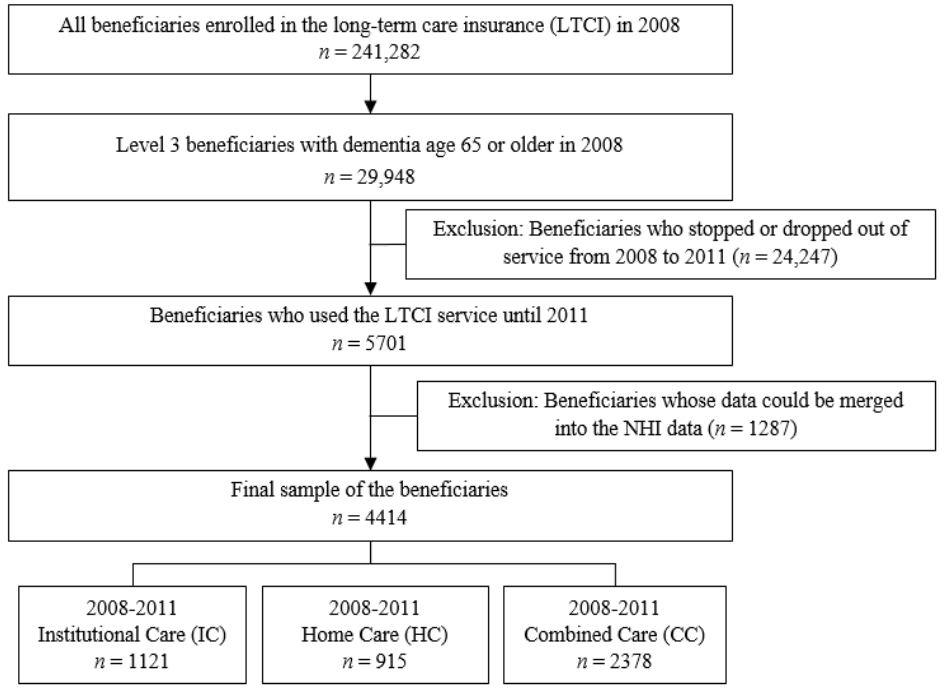
Figure 1. Study sample selection flow.